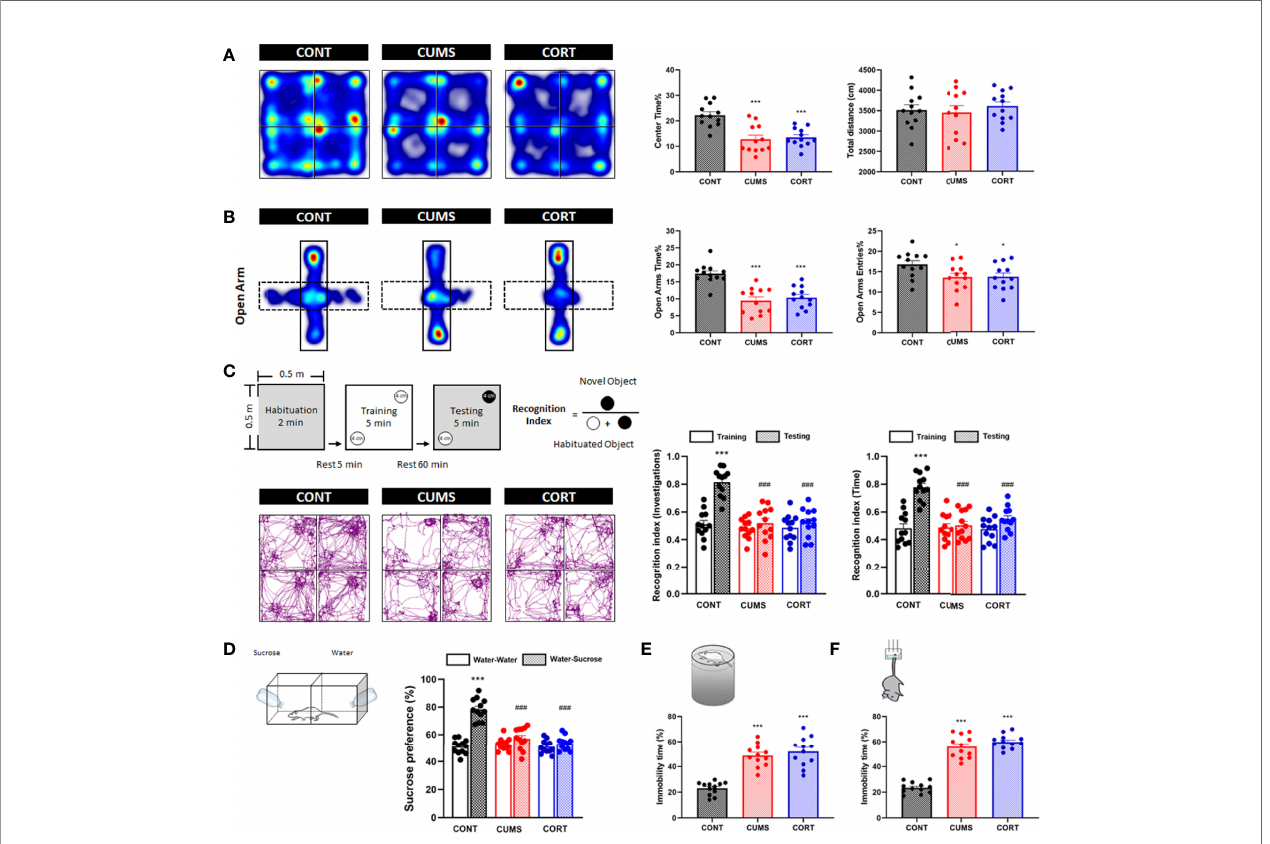
FIGURE 2 | Mice with chronic stress exhibited negative emotional behaviors. (A) Representative heat maps for CONT, CUMS, and CORT groups in OF test were presented, and center time% and total distance were analyzed (two-way ANOVA with Tukey ’ s post hoc test, *** P < 0.001, compared with CONT; n = 12). (B) Representative heat maps for CONT, CUMS, and CORT groups in EPM test were presented, and open arm time% and open arm entries% were analyzed (two- way ANOVA with Tukey ’ s post hoc test, * P < 0.05, *** P < 0.001, compared with CONT; n = 12). (C) Experimental protocol and representative trajectory images for CONT, CUMS, and CORT groups in NOR test were presented, and recognition index of investigations and time was analyzed (paired Student ’ s t -test, *** P < 0.001, compared with training. Two-way ANOVA with Tukey ’ s post hoc test, ### P < 0.001, compared with CONT-testing; n = 12). (D) Experimental protocol for SP test was presented, and sucrose preference was analyzed (paired Student ’ s t -test, *** P < 0.001, compared with water – water. Two-way ANOVA with Tukey ’ s post hoc test, ### P < 0.001, compared with CONT – water – sucrose; n = 12). (E) Experimental protocol for FS test was presented, and immobility time% was analyzed (two- way ANOVA with Tukey ’ s post hoc test, *** P < 0.001, compared with CONT; n = 12). (F) Experimental protocol for TS test was presented, and immobility time% was analyzed (Two-way ANOVA with Tukey ’ s post hoc test post hoc , *** P < 0.001, compared with CONT; n =